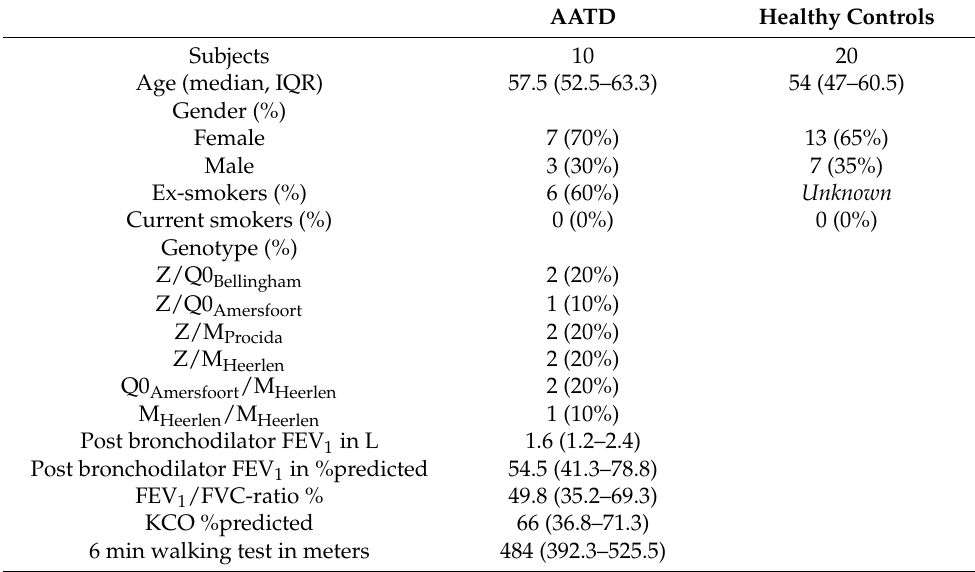
Table 1. Characteristics of study population. The data are presented as median with IQR and in percentages. None of the AATD patients had a history of an acute exacerbation 6 weeks prior to pulmonary function testing. The group of healthy controls were comparable qua age and gender to the AATD patients Abbreviations: IQR = interquartile range; FEV 1 = forced expiratory volume in one second; FVC = forced vital capacity; KCO = transfer coefficient of the lung for carbon monoxide.